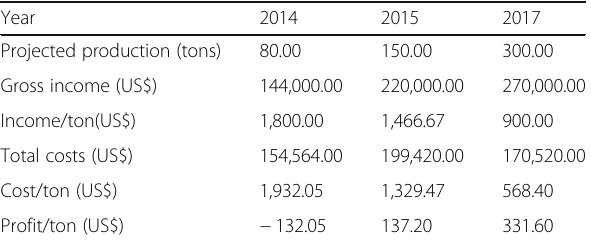
Table 1 Projected profitability of the soap processing